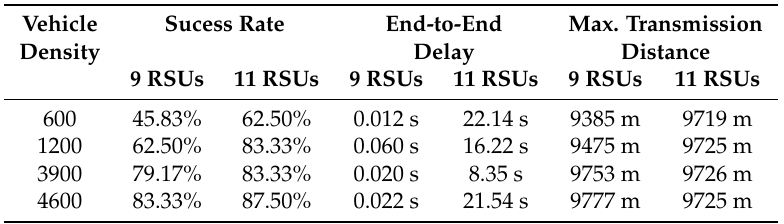
Table 9. Vehicular network